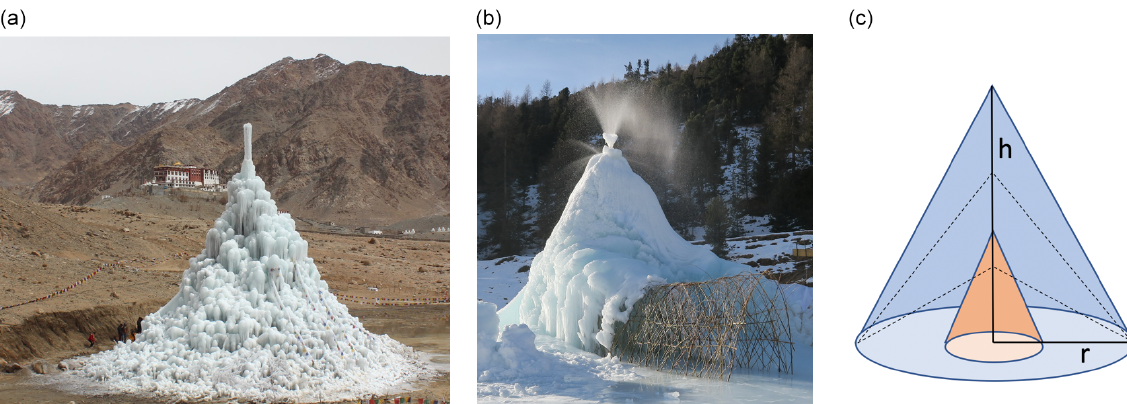
Figure 1. (a) Ice stupa in Ladakh, India (courtesy of Sonam Wangchuk). (b) Early growing stage of ice stupa with inner structure in Val Roseg, Switzerland (courtesy of Conradin Clavuot). (c) Simple geometrical representation. The ice stupa can have an inner structure (brown). The dashed lines illustrate the growth of an ice stupa from a base with a constant